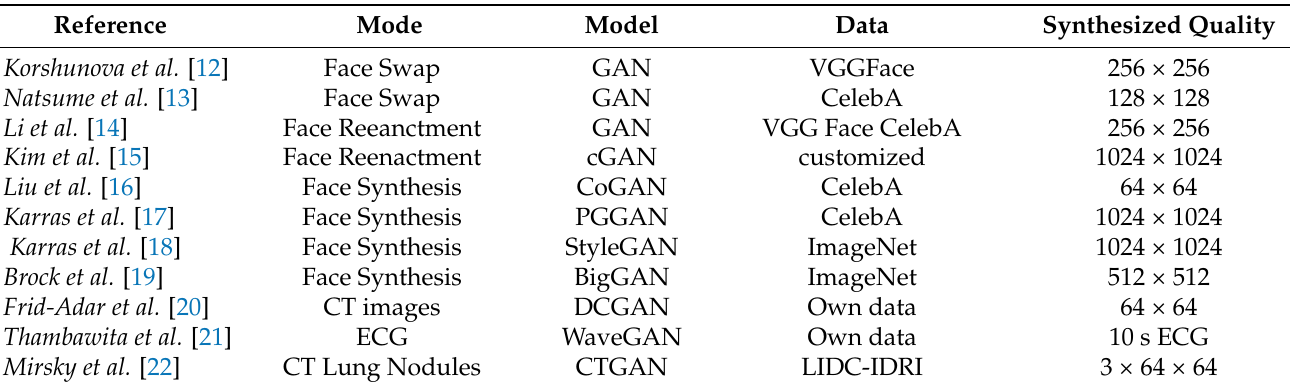
Table 1. Overview of Image Generation